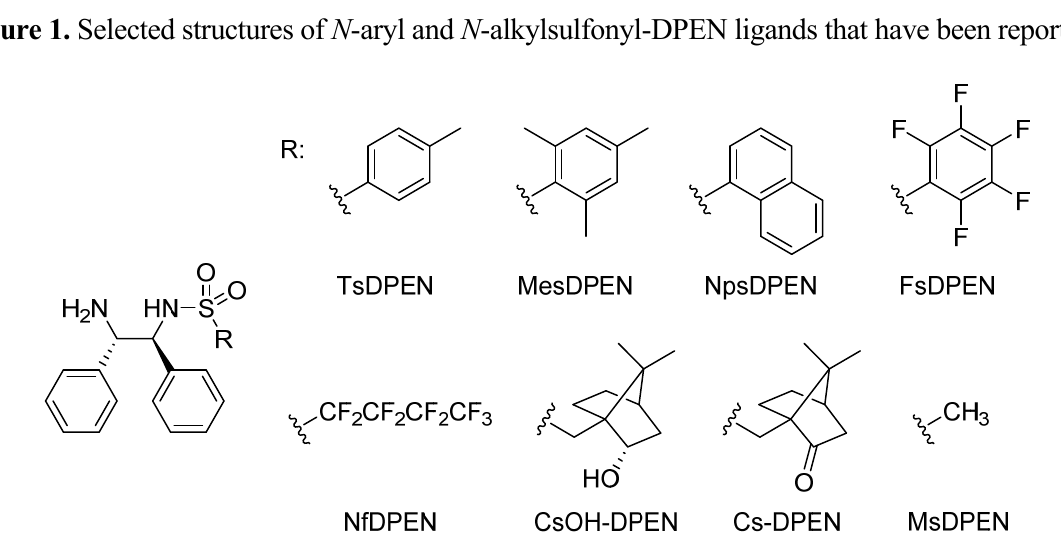
Figure 1. Selected structures of N -aryl and N -alkylsulfonyl-DPEN ligands that have been